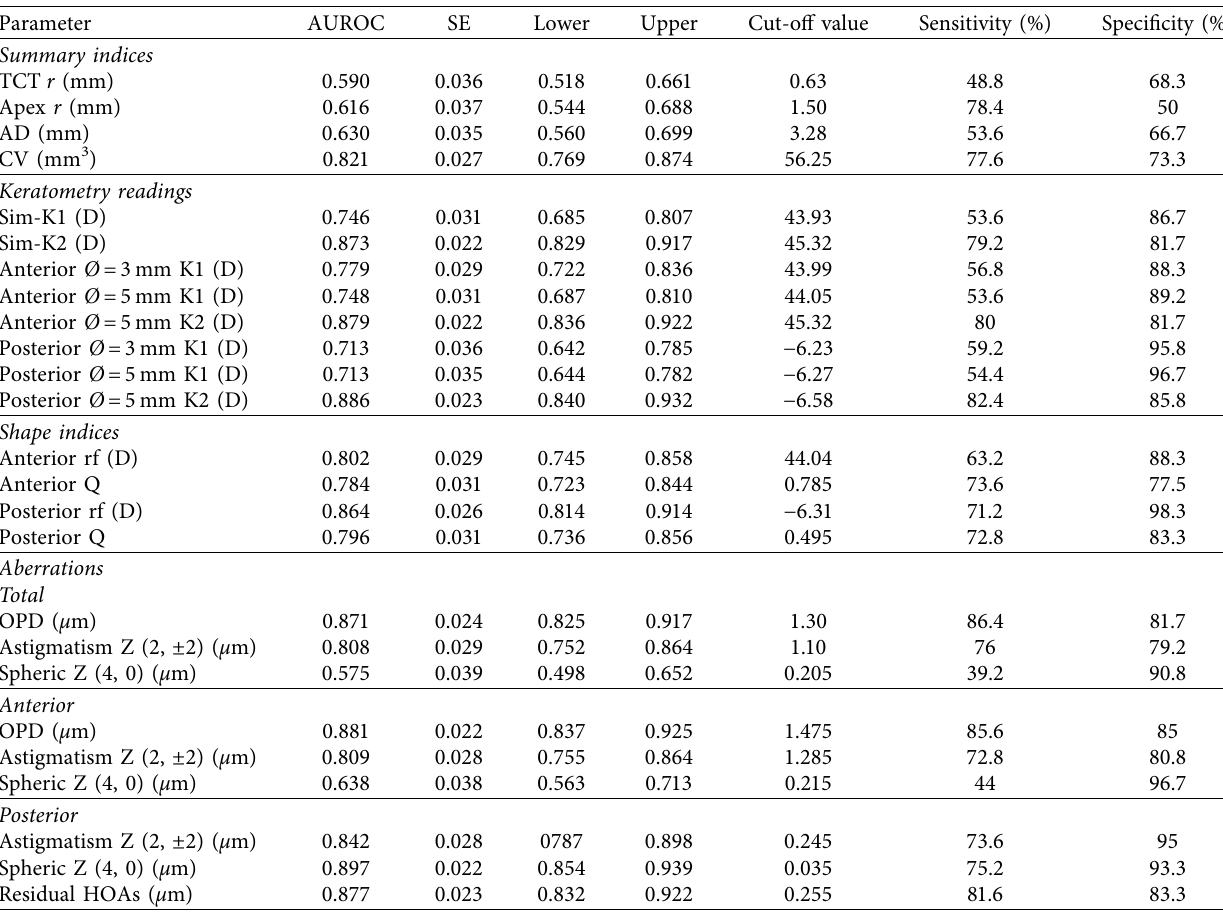
Table 3: Receiver operating characteristic (ROC) analysis of the parameters where AUROC values are less than 0.9 95% confidence interval. Parameter AUROC SE Lower Upper Cut-off